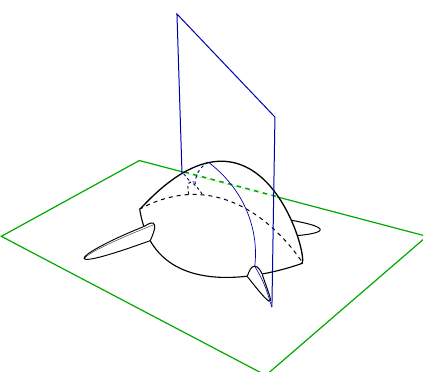
Figure 24. Tumor’s 3D outline and cut planes for case 5, the green one, and case 6, the blue one.